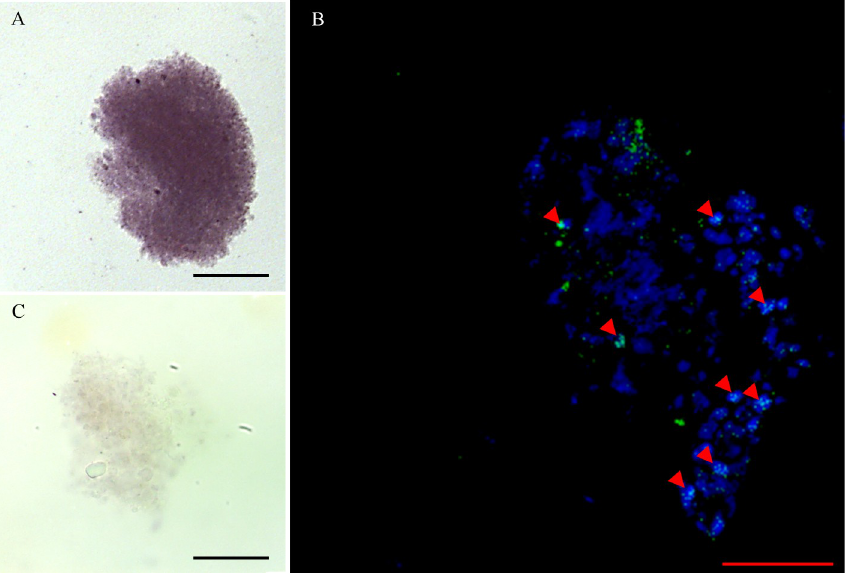
Fig 7. IF in proliferative cell clusters from racemose larvae. The clusters express plk1 (A) and were reactive to phospho histone H3 (arrowheads) (B) and the nuclei were stain with DAPI. A sense probe (C) was used as a negative control. Scale bar: 50 μ